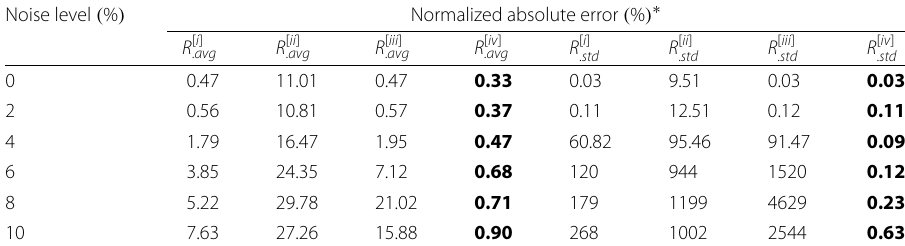
Table 2 The means and standard deviations of NAE O of the four algorithms Noise level ( % ) Normalized absolute error ( % )